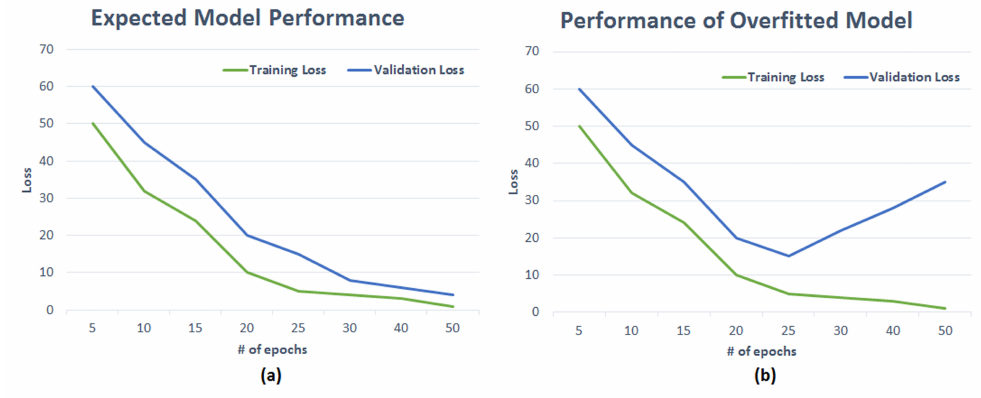
Figure 1. ( a ) Shows the ideal trend of the model with training and validation error functions decreasing almost simultaneously. ( b ) Shows the undesired effect of overfitting, having the training error decrease and, conversely, validation error increases suddenly.